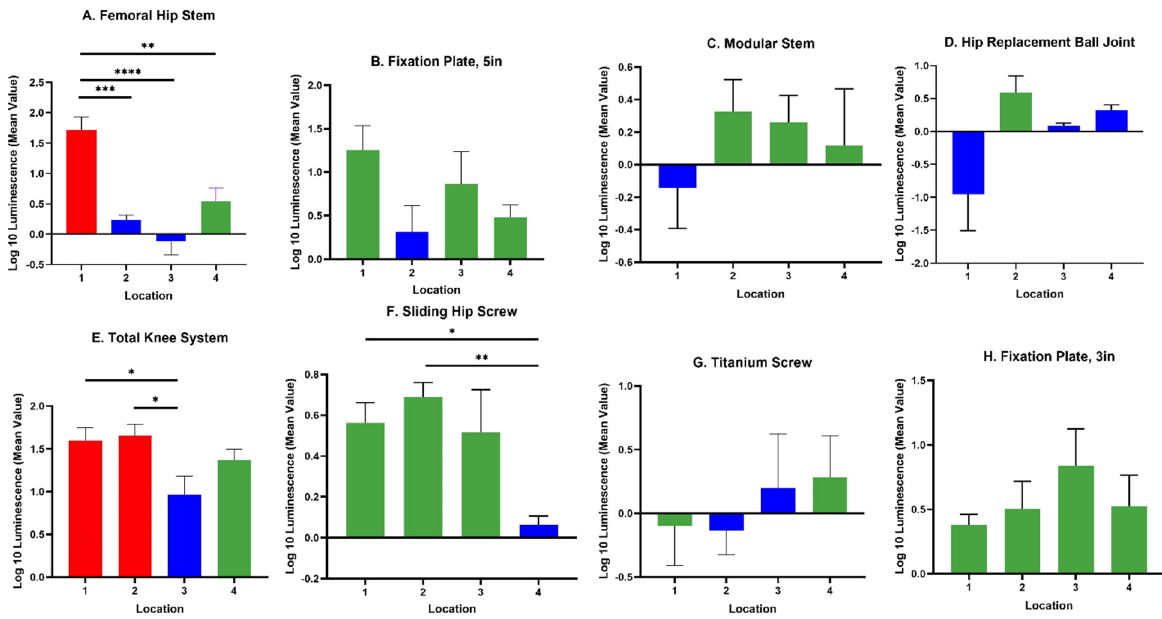
Figure 4. Luminescence quantification. Log 10 mean luminescence of four different locations on each implant. Red indicates rough surfaces, green indicates edges, and blue indicates a smooth surface. Geometric Average ± SE, n ≥ 3. (* p < 0.05, ** p < 0.01, *** p < 0.001, **** p < 0.0001). Across all implants, the rough surfaces (Ra ≥ 17 µm) indicated in red had the greatest luminescence compared to edges (green) and smooth surfaces (blue) (Figure 5). The luminescence quantified from the rough surfaces of the total knee and the femoral hip stem was significantly greater than the edges and/or smooth surfaces of those implants (Figure